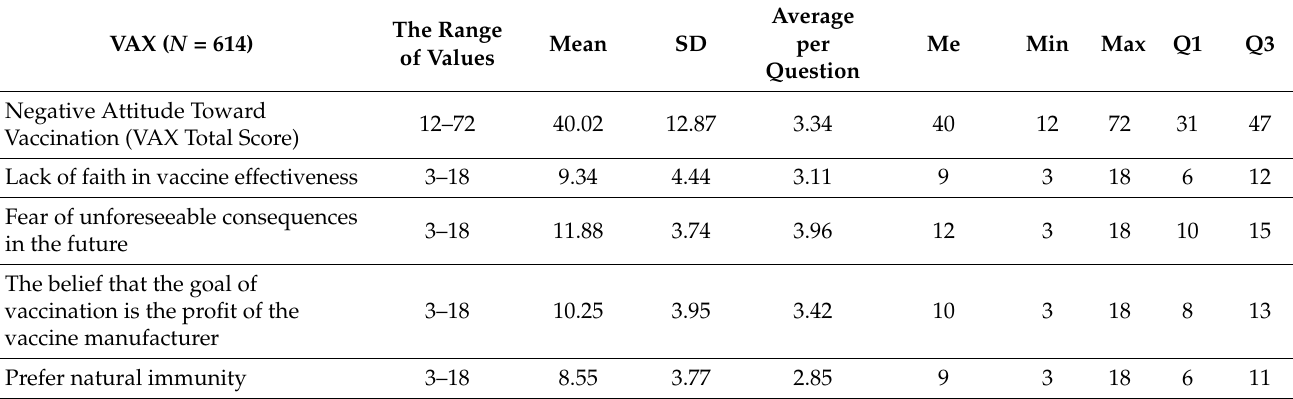
Table 4. Attitudes towards vaccination (VAX scale)–scores N = 614.